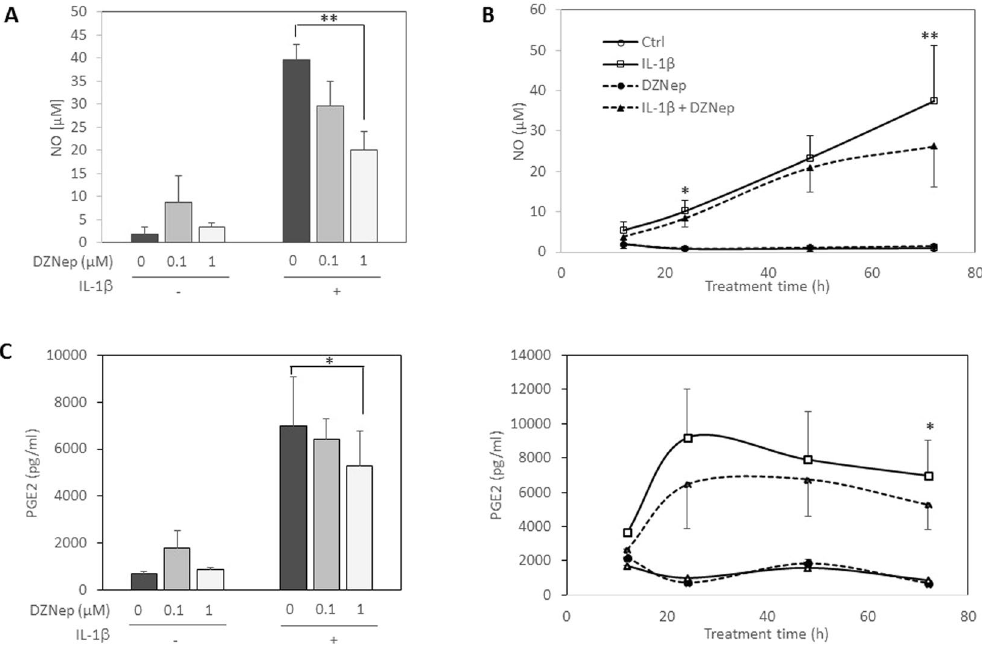
Figure 2. DZNep reduced NO and PGE2 production induced by IL-1 β . ( A ) Primary chondrocytes were treated or not with DZNep (0 µ M, 0.1 µ M or 1 µ M) in the presence or absence of IL-1 β (1 ng/mL) for 72 h. ( B ) Primary chondrocytes were treated or not with DZNep (1 µ M) in the presence or absence of IL-1 β (1 ng/mL) for 12 h, 24 h, 48 h or 72 h. After treatment, NO production was measured in culture medium by Griess reaction assay. ( C ) Cells were treated or not with DZNep (1 µ M) in the presence or absence of IL-1 β (1 ng/mL) for 72 h. After treatment, PGE2 was quantified in culture medium by ELISA assay. Data are expressed as means ± SEM. Statistical significance between “IL-1 β ” and “IL-1 β + DZNep” conditions are represented. * p-value ≤ 0.05; ** p-value ≤